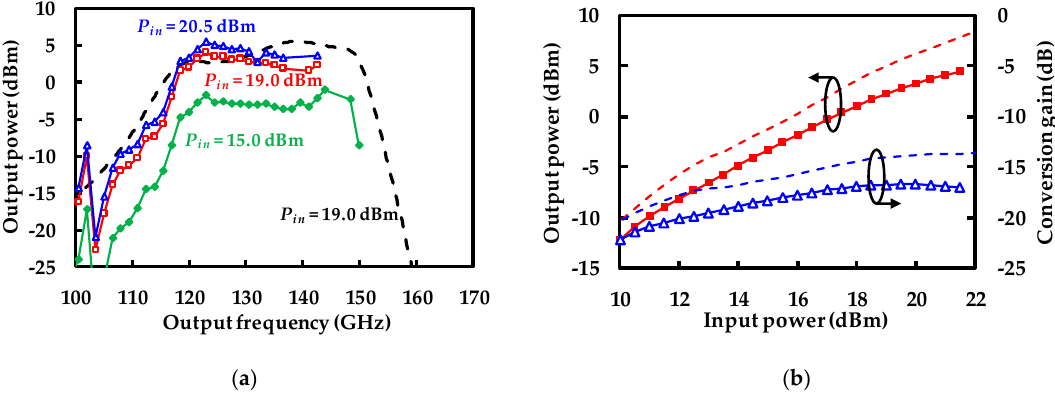
Figure 14. Measured output power and conversion gain (solid: measurement, dashed: simulation). ( a ) Output power versus frequency at certain input powers ( P in ). ( b ) Conversion gain and output power versus input power at output frequency of 135 GHz.